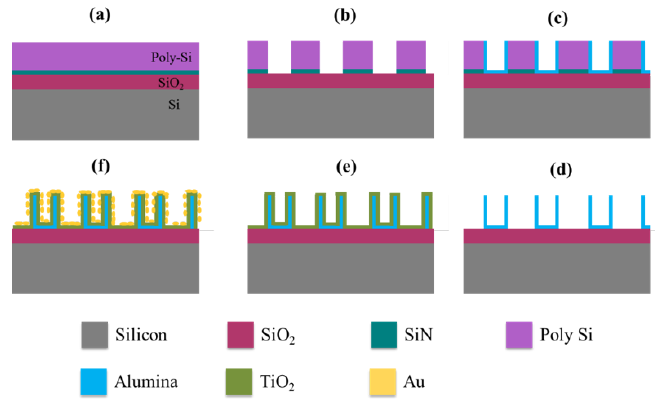
Figure 11. Schematic pictures of the fabrication steps: ( a ) ~100 nm of thermally deposited SiO 2 , ~150 nm of SiN, and 500 nm of poly Si were deposited via low pressure chemical vapor deposition (LPCVD) process. ( b ) The poly Si layer was subsequently patterned with a UV stepper and then etched with RIE. The SiN layer was etched due to over etching. ( c ) Nearly 40 nm of Al 2 O 3 (alumina) was conformally deposited using atomic layer deposition (ALD) and then anisotropically etched using RIE, leaving only the sidewalls. ( d ) The poly Si layer was etched via XeF 2 gas etching leaving only vertically the standing alumina sidewalls. ( e ) Then, TiO 2 was deposited on the alumina shells using the isotropic ALD deposition. ( f ) Finally, the structures were decorated with Au nanoparticles by using a sputter deposition.